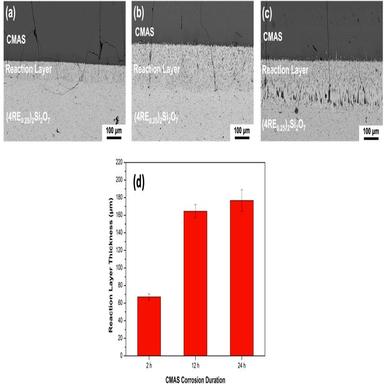
Cross-sectional SEM micrographs of (Y0,25Er0,25Tm0,25Yb0,25)2Si2O7 samples exposed to CMAS corrosion at 1300 ◦C for (a) 2 h, (b) 12 h, (c) 24 h and (d) the reaction layer thickness bar chart after CMAS corrosion tests.